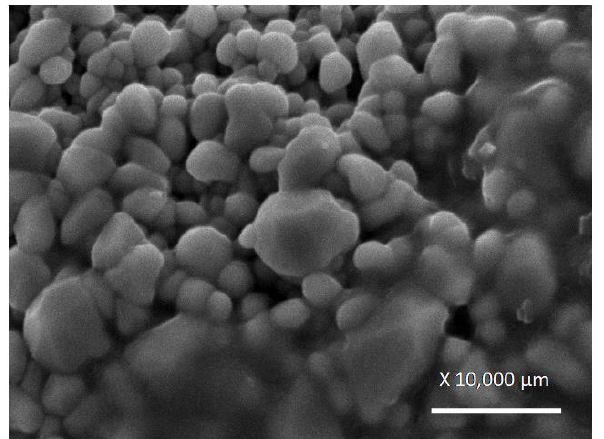
Figure 4. SEM study made at 8 h of milling.